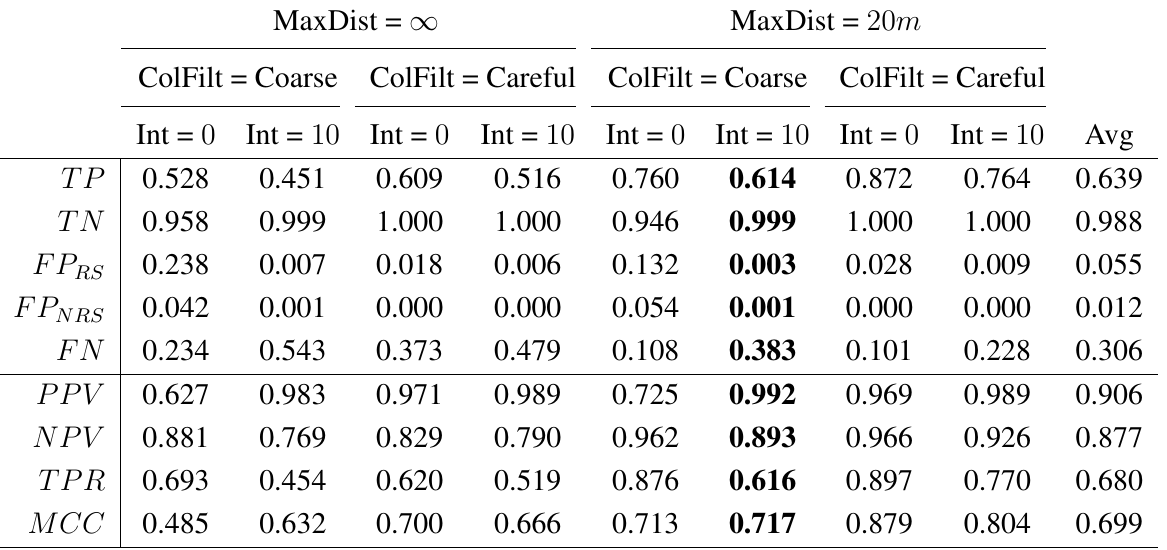
Table 2. Classification results of the detection and tracking algorithm. We have analysed eight different scenarios by varying: MaxDist (maximum distance at which we require the cameras to detect the robot), ColFilt (whether the colour filters have been coarsely or carefully adjusted), and Int (time persistence interval). The typical configuration that we use on robot control experiments (like those on Section 6) is remarked in boldface.